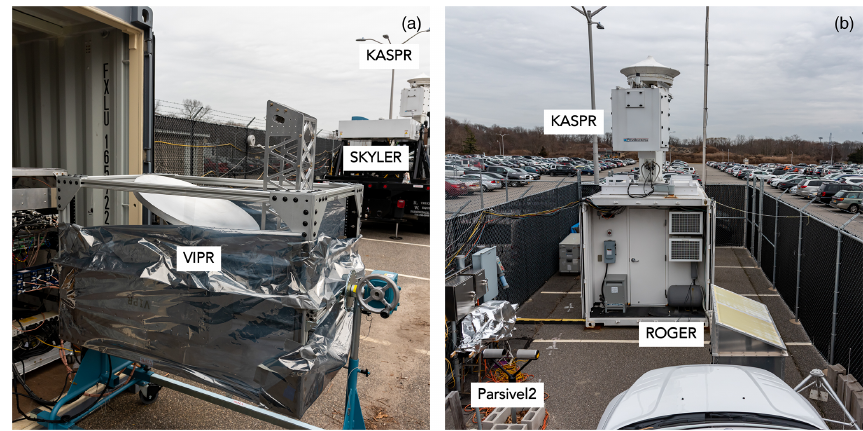
Figure 1. (a) Picture of the VIPR G-band radar system when it was deployed at the Stony Brook Radar Observatory. Also deployed at the observatory was a truck-mounted X-band phased-array radar named SKYLER (visible in panel a ), the container-mounted parabolic-dish Ka-band radar named KASPR (visible in panels a and b ), the FMCW W-band radar named ROGER (visible in panel b ) and a Parsivel 2 disdrometer (visible in panel b